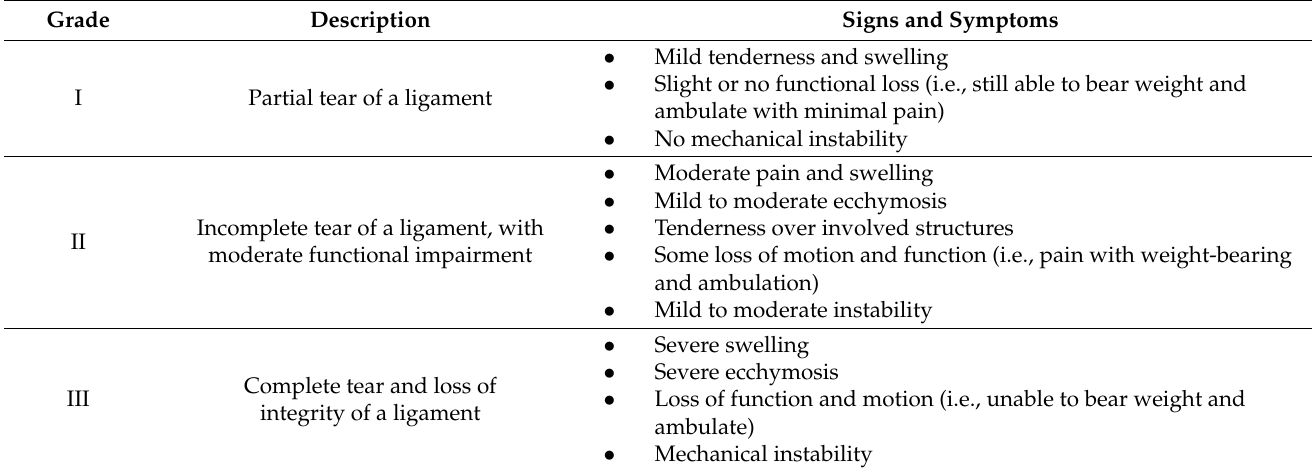
Table 1. Classification of ankle sprain injuries (Adapted from ref.